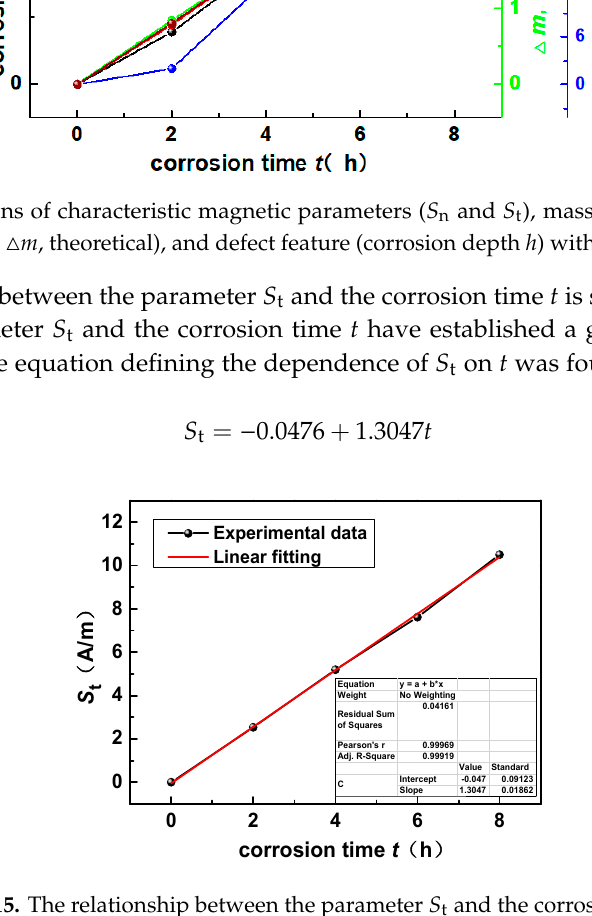
Figure 15. The relationship between the parameter S t and the corrosion time t .